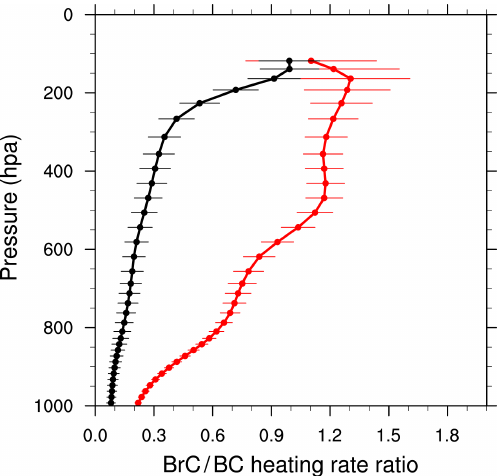
Figure 14. Global averaged vertical profile of the BrC-to-BC heat- ing rate ratio for 2010. The black and red lines are the average pro- files for regions without and with deep-convection events, respec- tively. Standard deviations are indicated by the horizontal